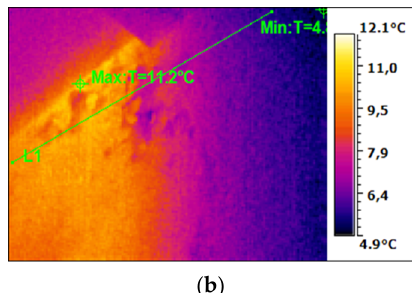
Figure 6. Thermal ( a ) image of the temperature distribution on the surface of the chimney wall in visible light ( b ).